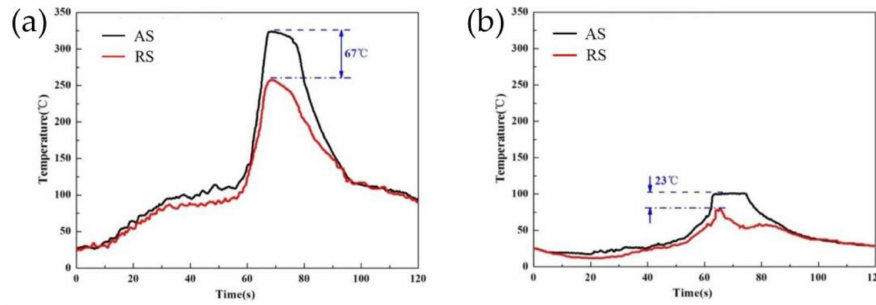
Figure 17. ( a , b ) show the thermal curves of joints under air cooling conditions and externally assisted cooling conditions, respectively [55].